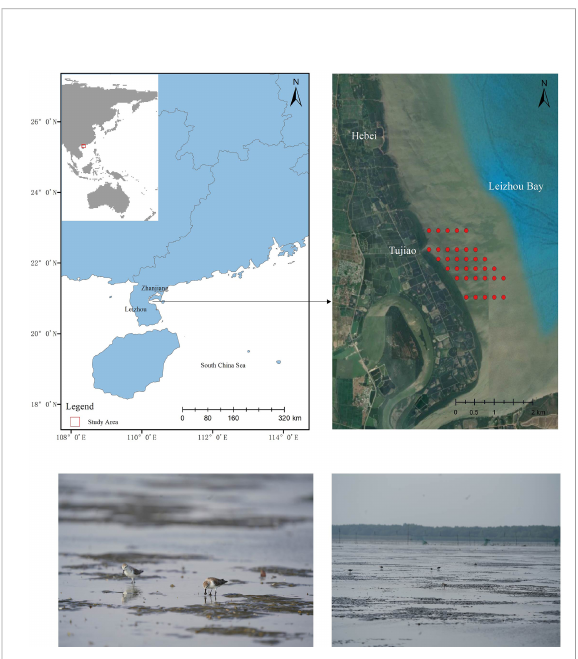
FIGURE 1 Map (above) and landscape (below) of the study sites situated in Leizhou Bay in the South China Sea: Tujiao and Hebei. Benthos and sediment sampling stations along transects in the intertidal mud fl ats are shown.